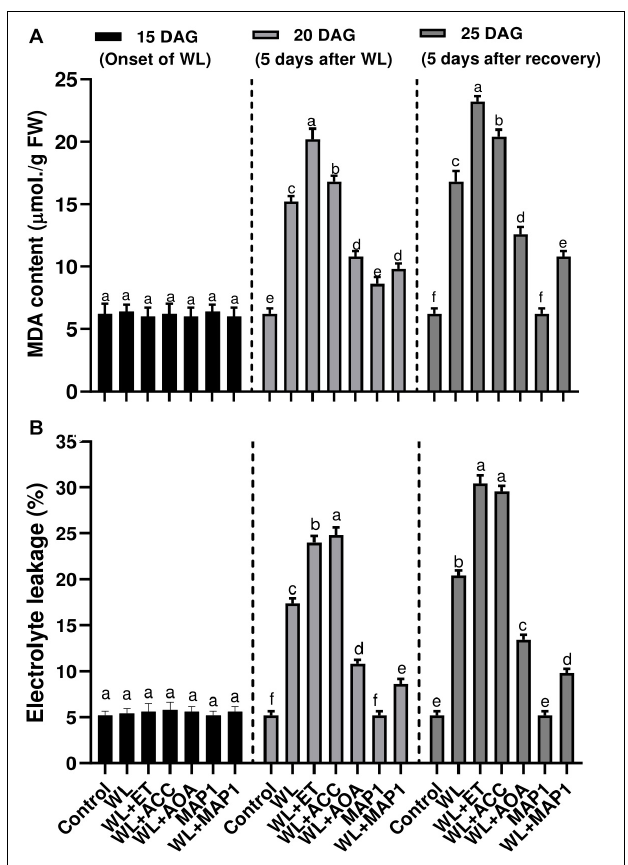
FIGURE 6 | Effect of WS on (A) MDA content and (B) leaf electrolyte leakage in wheat plants with and without MAP1 inoculation, exposed to WS. Quantitative data represent means ± SD of three independent experiments and at least six technical replicates each. Different letters indicate statistically significant differences between treatments ( p ≤ 0.002, DMRT).